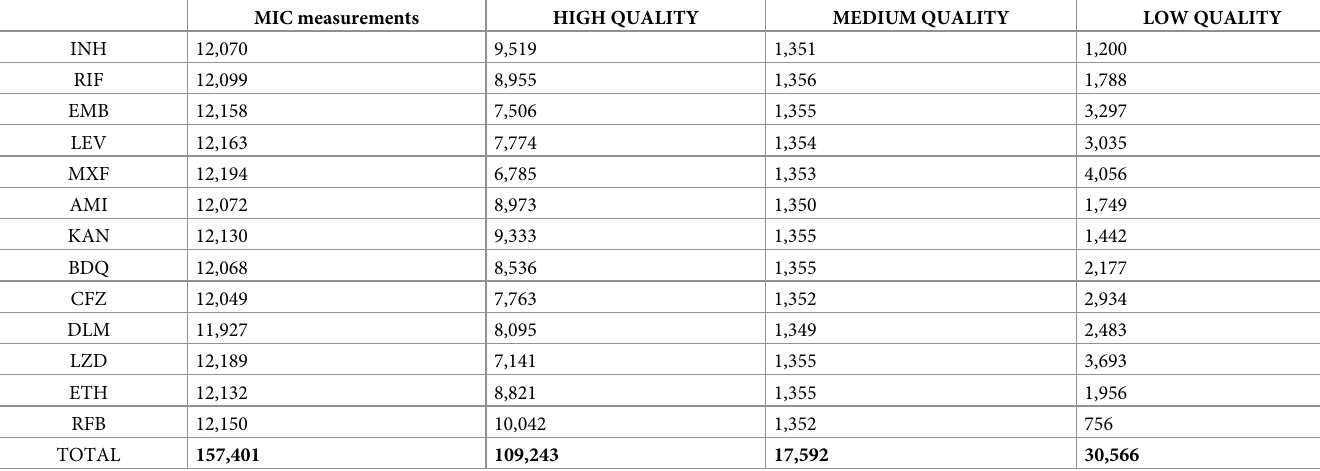
Table 1. Quality metrics for phenotype